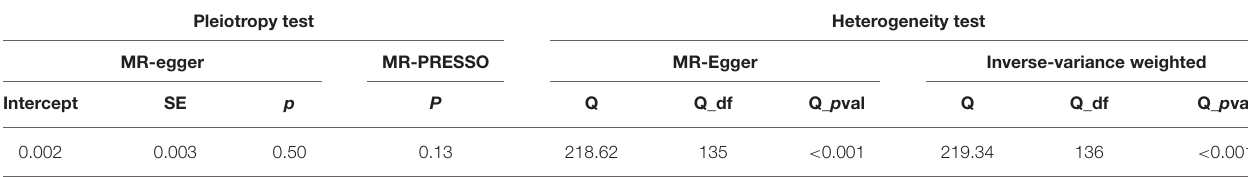
TABLE 4 | Pleiotropy and heterogeneity test of the 25-hydroxyvitamin D genetic IVs from in Heart failure GWAS.